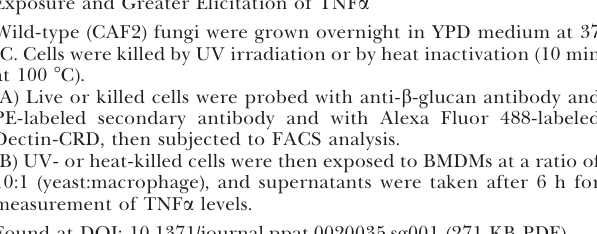
Figure S1. Heat Inactivation of C. albicans Causes Greater b -Glucan Exposure and Greater Elicitation of TNF a Wild-type (CAF2) fungi were grown overnight in YPD medium at 37 8 C. Cells were killed by UV irradiation or by heat inactivation (10 min at 100 8 C). (A) Live or killed cells were probed with anti- b -glucan antibody and PE-labeled secondary antibody and with Alexa Fluor 488-labeled Dectin-CRD, then subjected to FACS analysis. (B) UV- or heat-killed cells were then exposed to BMDMs at a ratio of 10:1 (yeast:macrophage), and supernatants were taken after 6 h for measurement of TNF a levels. Figure S2. Overlap of b -Glucan Cell Wall Architecture Screen with Other Cell Wall-Related Screens We examined the intersection (A) between the genes required for b - glucan masking (shown in green) and those identified by any one of four other genome-wide cell wall-directed screens (shown in dark red). These included (B) a screen to find mutants with synthetic lethality with genes required for b 1,3-glucan biosynthesis (shown in dark blue [1]), (C) a screen for mutants with altered sensitivity to caspofungin (shown in light blue [1]), (D) two screens for mutants with altered sensitivity to the chitin-binding drug calcofluor white (shown in orange [2]), and (E) a screen for mutants with altered sensitivity to the cell wall-directed K1 killer toxin (shown in purple [3]). Found at DOI: 10.1371/journal.ppat.0020035.sg002 (489 KB PDF). Figure S3. The Unmasked S. cerevisiae gas1 D Mutant Hyperelicits TNF a from Primary Macrophages BMDMs were exposed to different S. cerevisiae strains at a ratio of 5:1 (yeast:macrophage). After fungi were added, macrophages were incubated for 6 h at 37 8 C, and supernatants were collected for TNF a quantitation. Found at DOI: 10.1371/journal.ppat.0020035.sg003 (505 KB PDF). Figure S4. Unmasked C. albicans Mutants Hyperelicit IL-6 from Macrophages through the b -Glucan Receptor BMDMs were pretreated for 20 min on ice with medium or soluble b - glucan (laminarin), and were then exposed to different C. albicans strains at a ratio of 10:1 (yeast:macrophage). After unbound fungi were washed off, macrophages were incubated for 6 h at 37 8 C, and supernatants were collected for IL-6 quantitation. Figure S5. Complementation of C. albicans Mutations Partially or Fully Reverses b -Glucan Exposure Phenotype Wild-type or mutant C. albicans strains were grown overnight in YPD, then stained with anti- b -glucan antibody and PE-labeled secondary antibody. Overlay histograms of FACS analysis of PE-labeled cells; data on 20,000 cells is shown. MFI values for wild-type and mutants are shown in insets. The partial reduction in b -glucan exposure (for PHR2 ) (A) or full reversal (for KRE5 ) (B) correlates with other phenotypes observed for these complemented strains [1–3]. Table S1. Overall Phenotype of Hypereliciting Mutants Found at DOI: 10.1371/journal.ppat.0020035.st001 (106 KB DOC). Table S2. Characterization of Exposed Mutants That Do Not Hyperelicit Cytokines Found at DOI: 10.1371/journal.ppat.0020035.st002 (70 KB DOC). Table S3. Fungal Strains Found at DOI: 10.1371/journal.ppat.0020035.st003 (66 KB